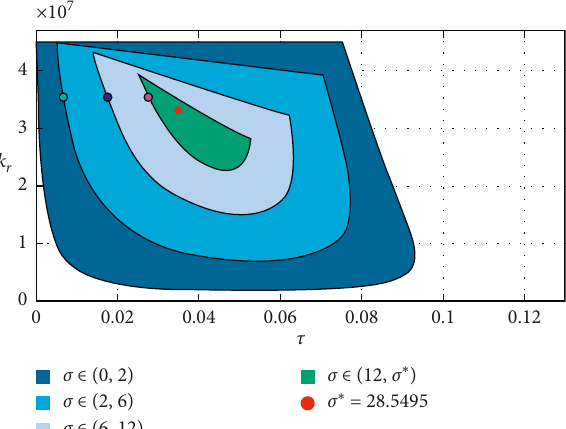
Figure 4: σ ∗ -stability region.